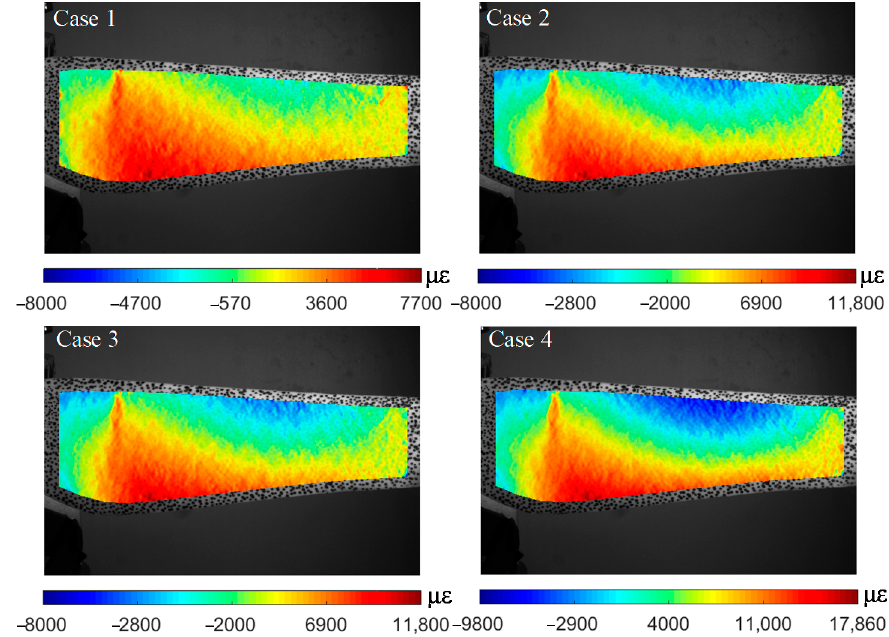
Sensors 2022 , 22 , x FOR PEER REVIEW Figure 8. Full-field strain distribution of the blade at different cases. Figure 8. Full-field strain distribution of the blade at different cases.